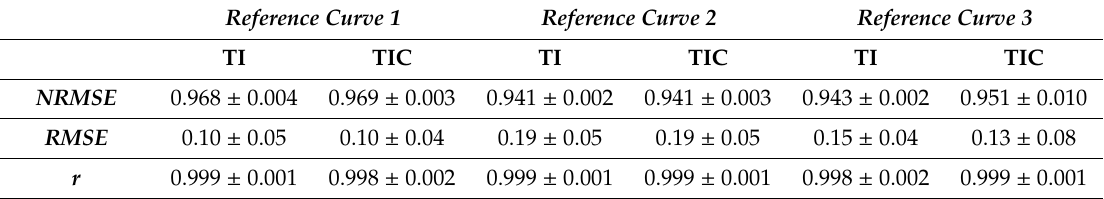
Table 8. Normalized root mean square error ( NRMSE ), root mean square error ( RMSE ), in kg, and Pearson correlation coe ffi cient ( r ) for the comparison between the bodyweight curve obtain following the suggestions from the MPC systems using the time-invariant parameters transfer function model, without (TI) and with constraints (TIC) and the three theoretical bodyweight reference curves generated.